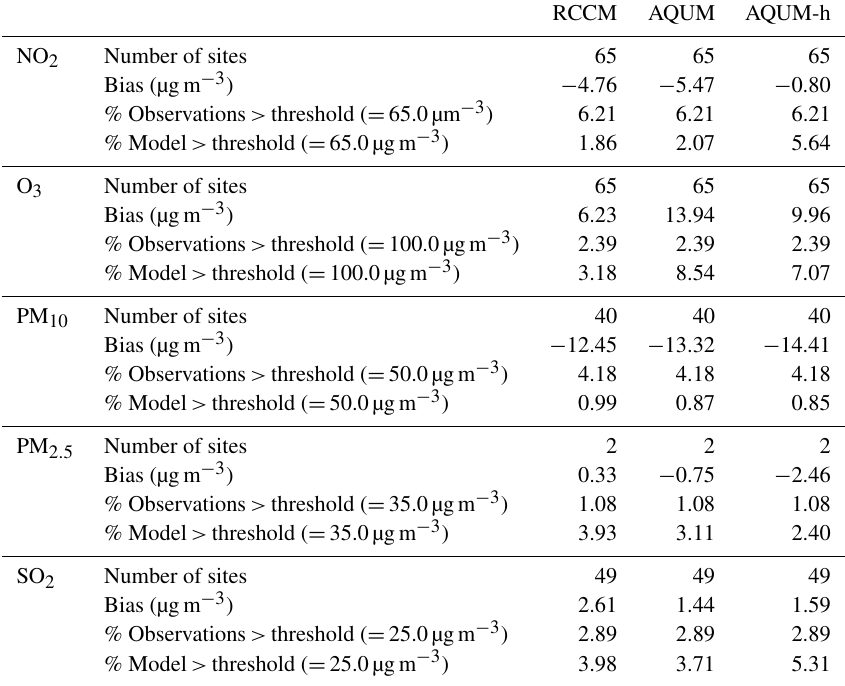
Table 2. Statistics comparing modelled air pollutant concentrations to AURN observations, for the period of the observational record 1 Jan- uary 2001–31 December 2005 (for the correlation between model years and the observational record compare the discussion in the text).